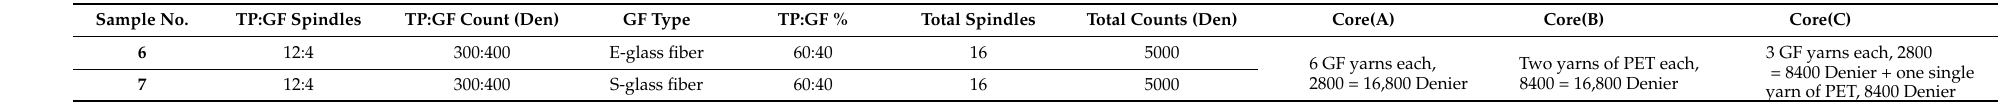
Table 6. Different setups for the braiding structure using the sized E- and S -glass